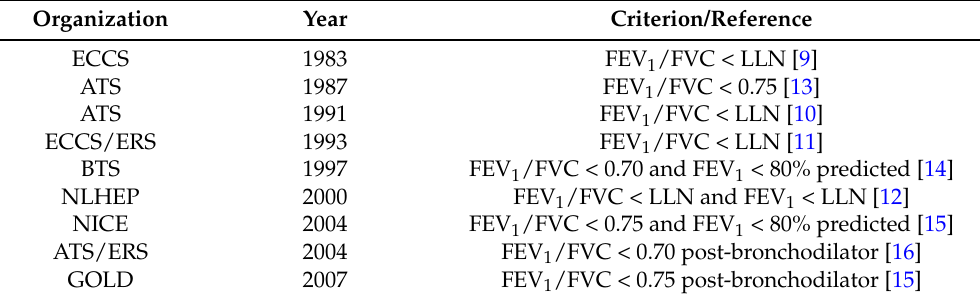
Table 1. Criteria for assessing COPD according to various organizations